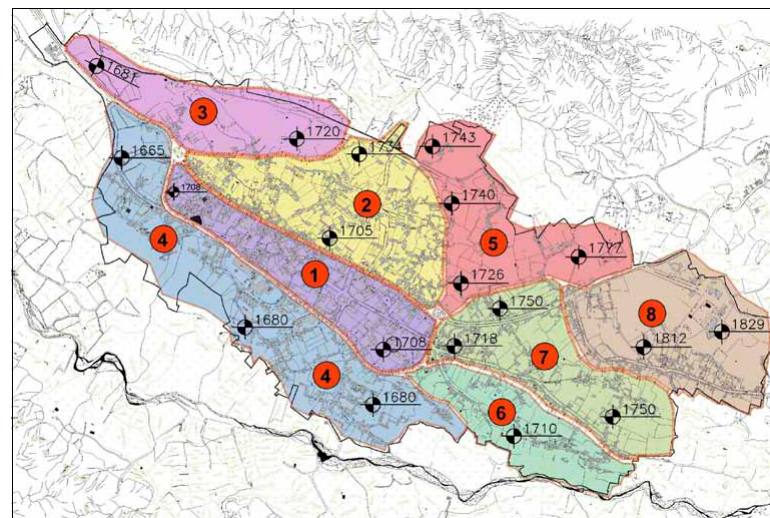
fig. 2. The blocked city (created by author)